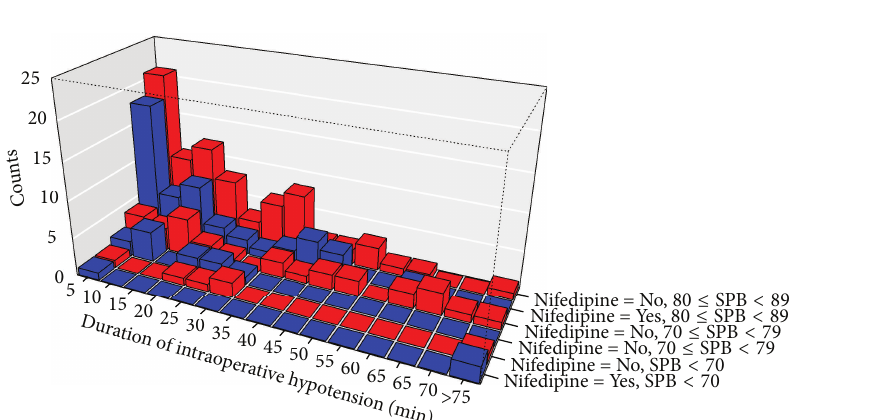
Figure 2: Severity and duration of intraoperative maternal hypotension in the patients during selective fetoscopic laser photocoagulation under epidural anesthesia. 𝑦 -axis represented the number of patients in nifedipine exposure group (blue color) and nonexposure to nifedipine group (red color). 𝑥 -axis represented the duration of hypotension in